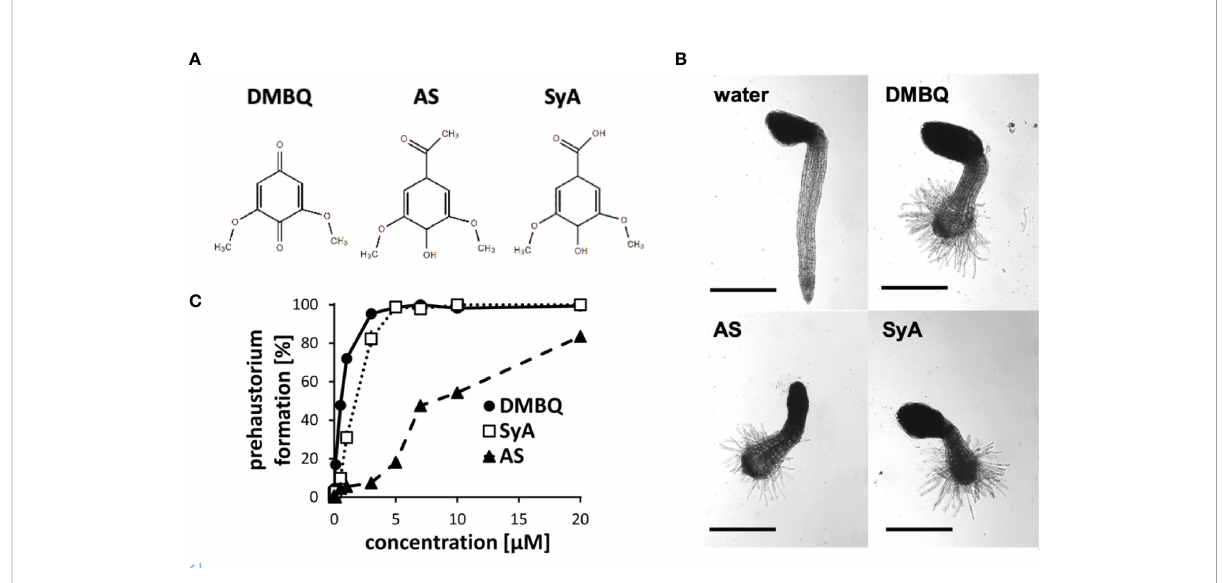
FIGURE 1 Prehaustorium induction by phenolic compounds acetosyringone and syringic acids. (A) Chemical structures of HIFs. DMBQ: a quinone. Acetosyringone (AS) and syringic acid (SyA): the phenolics. (B) Representative images of S. hermonthica seedings treated without (water) or with HIFs for 24 h upon germination. (C) Prehaustorium inducing activity of DMBQ (10 µM), AS (50 µM) and SyA (20 µM) after 24 h of treatment. Data represents mean ± SE with three replicates. Scale bars = 500